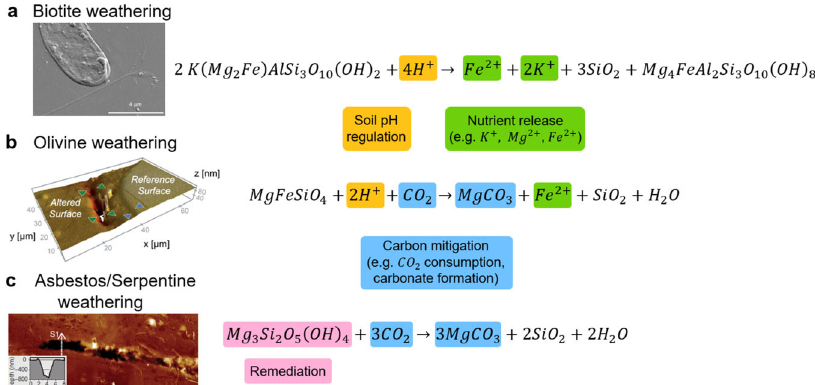
Fig. 4 Examples of silicate minerals for which the local contribution of microorganisms (fungal hyphae) to mineral dissolution was assessed experimentally in a quantitative manner, using microscopy techniques. Examples include biotite ( a ), olivine ( b ), and serpentine ( c ); simpli fi ed theoretical equations for their dissolution are provided. These minerals could — in theory — present interesting bene fi ts for agricultural purposes (nutrient release, highlighted in green, and soil pH regulation, in yellow), carbon mitigation (consumption of atmospheric CO 2 , blue), or remediation (e.g., asbestos dissolution, pink) 259 . Images of biotite, olivine and serpentine weathering from ref. 91 , ref. 123 , and ref. 92 ,